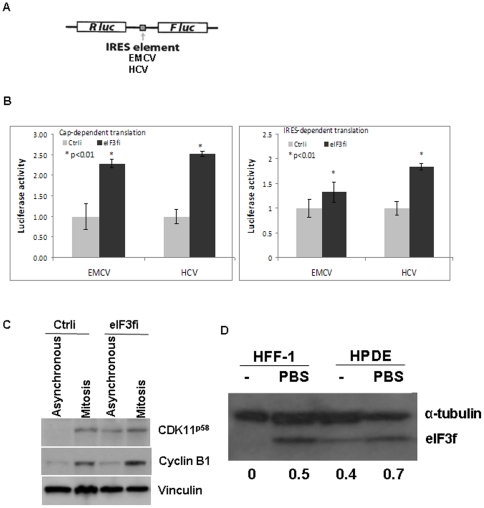
eIF3f inhibited both cap-dependent and IRES-dependent translation.(A) The map of the pRF bicistronic luciferase reporter (Renilla luciferase [Rluc], Firefly luciferase [Fluc]) constructs contained 1 of the 2 IRES elements of EMCV or HCV. (B) Same number of control and eIF3f-silenced HPDE cells were transfected with the same amount of 1 of the pRF bicistronic luciferase constructs. Dual luciferase assay for both firefly and renilla luciferase activity was performed 24 hours after transfection according to the manufacturer's instructions (Promega). Relative luciferase activity compared to control RNAi cells from 3 independent experiments was shown. (C) Control and eIF3f-silenced HPDE cells were either asynchronous or treated with nocodazole (40 ng/ml) for 16 h to block the cells in G2/M phase. Cells were harvested and Western blot was performed using CDK11, cyclin B1 and vinculin antibodies. Note that CDK11p58 expression was present only in mitotically synchronized control cells, but was also present in asynchronous eIF3f-silenced cells because of increased IRES activity in its 5′UTR. Cyclin B1 expression confirmed the G2/M phase. Vinculin was used as loading control. (D) Starvation led to increased eIF3f protein level. HFF-1 and HPDE cells either were cultured in regular medium or were starved for 6 hours in PBS before harvest. Western blot is performed to determine eIF3f protein level. Densitometric analysis of the eIF3f bands normalized to corresponding α-tubulin is shown at the bottom.